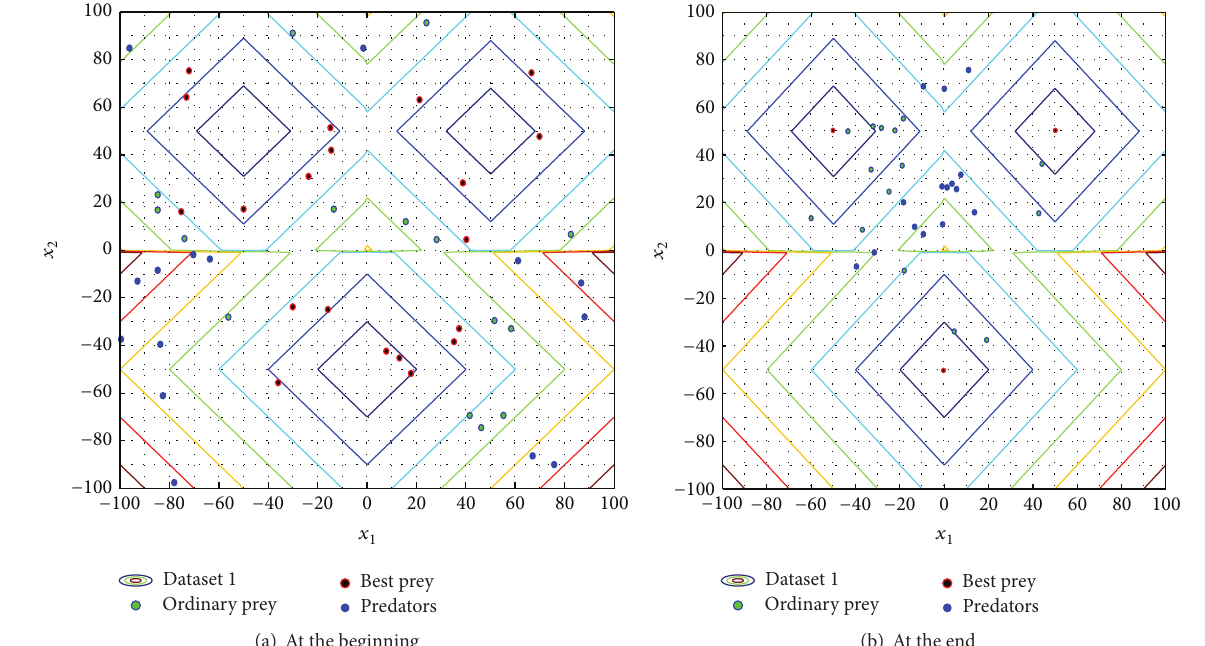
Figure 5: Location of solutions at the beginning and the end of running 𝑛𝑚 -PPA for problem two.